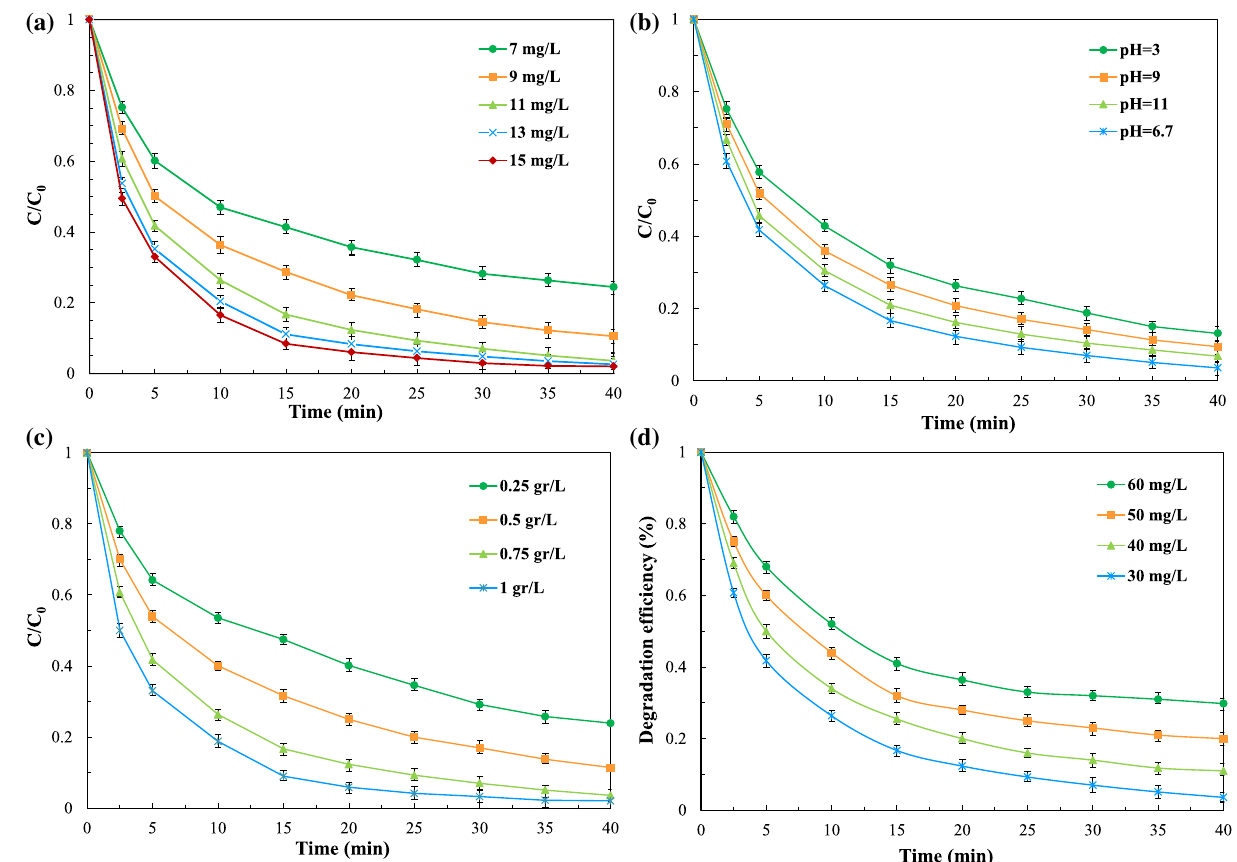
Figure 10. The influence of different parameters on the PhP degradation in the O 3 + PTL/Ar system ( a ) ozone concentration ([PhP] 0 = 30 mg/L, catalyst dosage = 0.75 g/L, pH 0 = 6.7), ( b ) initial solution pH ([PhP] 0 = 30 mg/L,